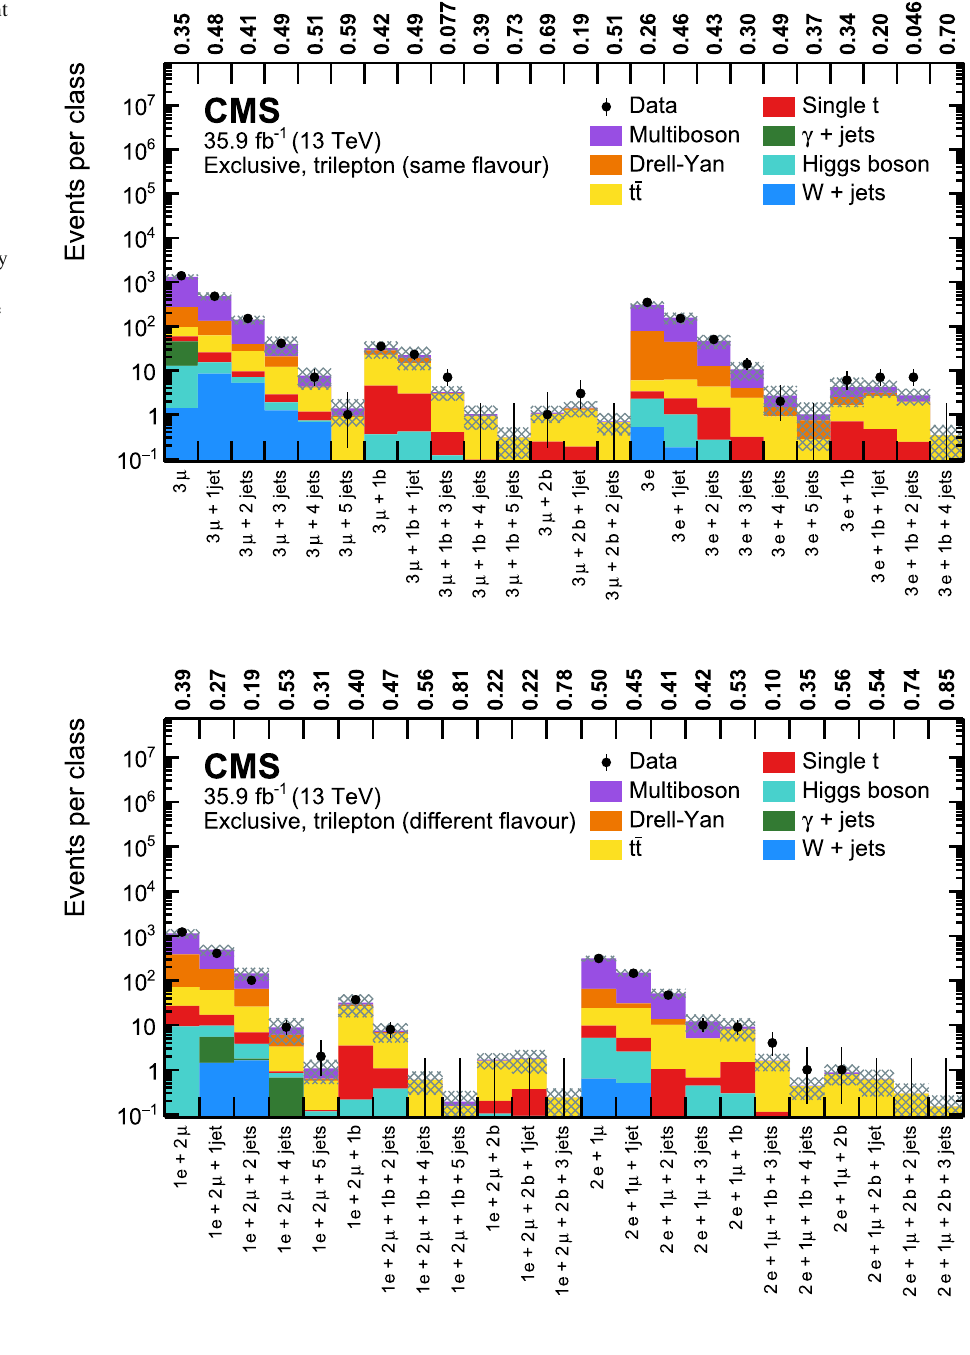
Fig. 20 Overview of total event yields for the event classes of the three-lepton object groups with same flavour (upper) and different flavour (lower). Measured data are shown as black markers, contributions from SM processes are represented by coloured histograms, and the shaded region represents the uncertainty in the SM background. The numbers above the plot indicate the observed p value for the agreement of data and